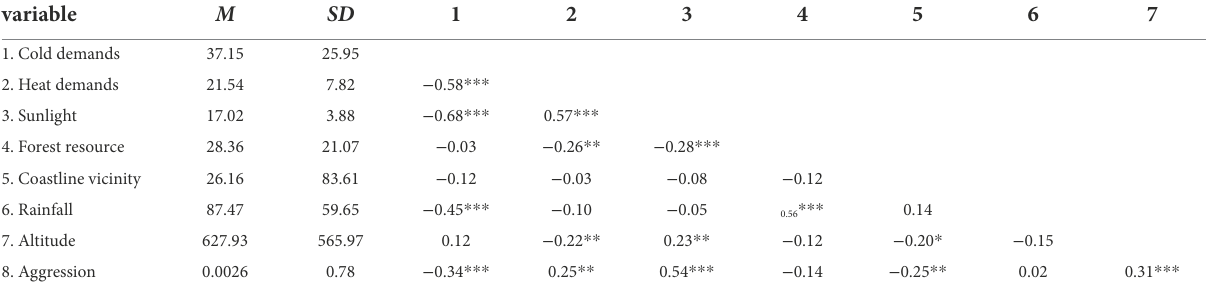
TABLE 1 Correlations among research variables ( N =